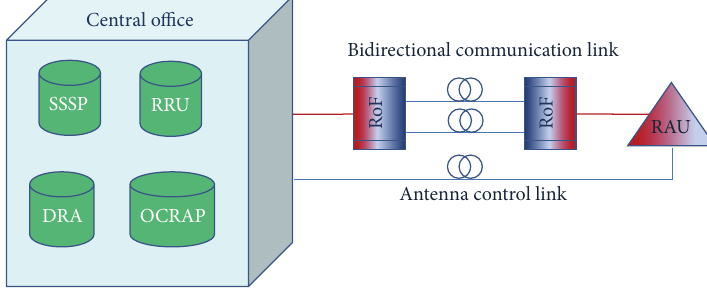
Figure 3: Block diagram of the optical-wireless network implementation.